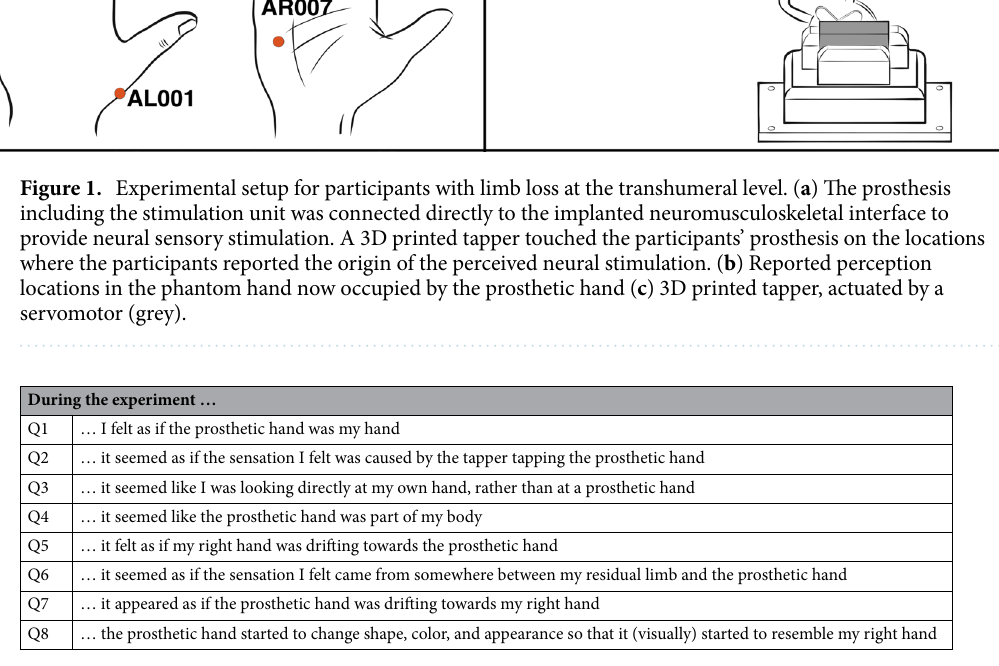
Table 4. The standard RHI questionnaire adapted to fit an experiment with tapping stimulation on a rubber hand. The first four questions are adapted from Longo et al. 64 and are used to establish if the ownership illusion was successful. The other four questions are control